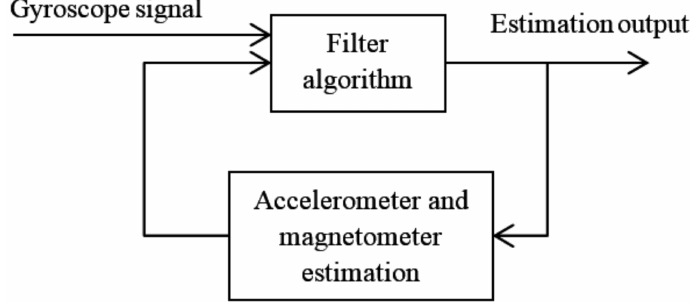
Figure 9. Main structure of the sensor fusion approach using accelerometer and magnetometer